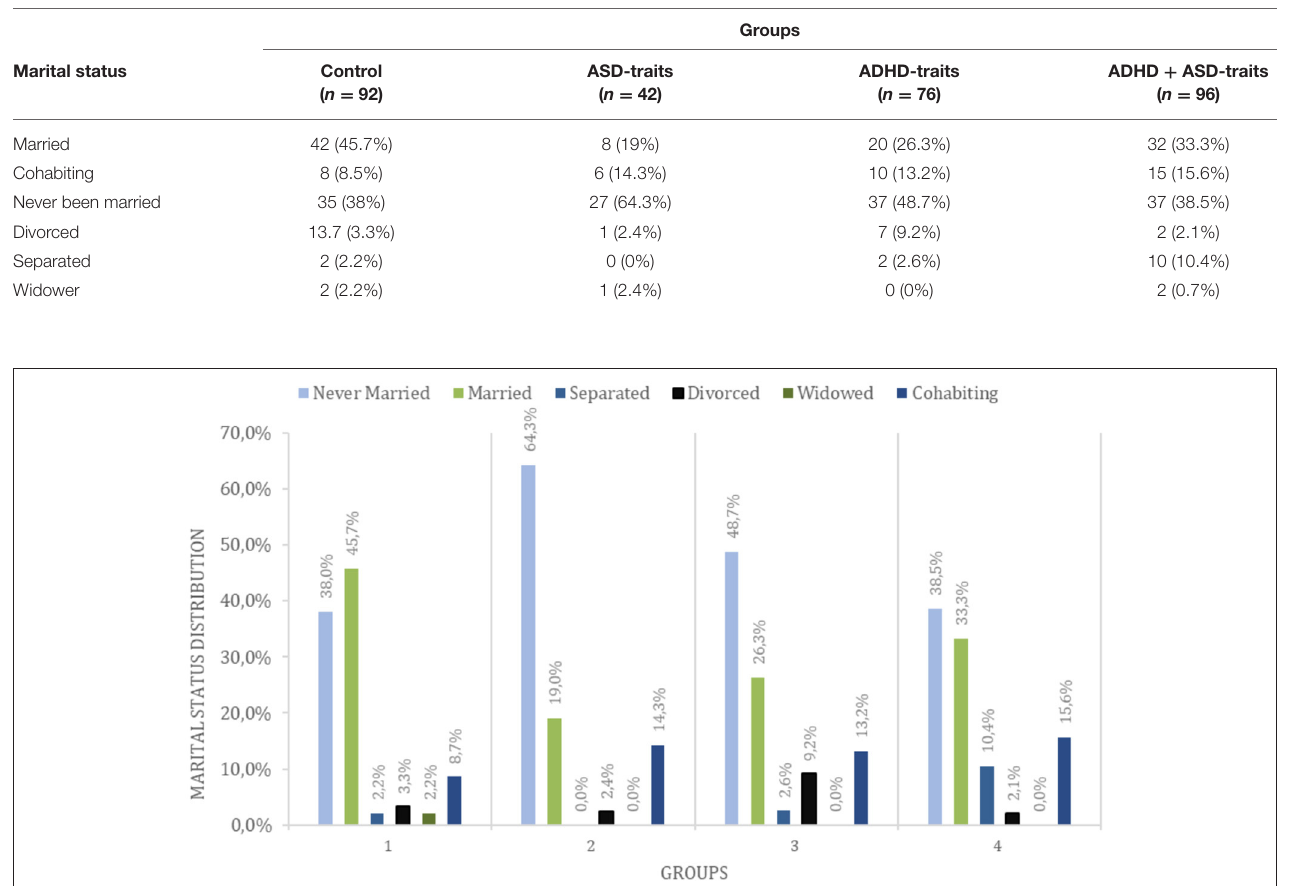
TABLE 2 | Marital status’ distribution among groups.